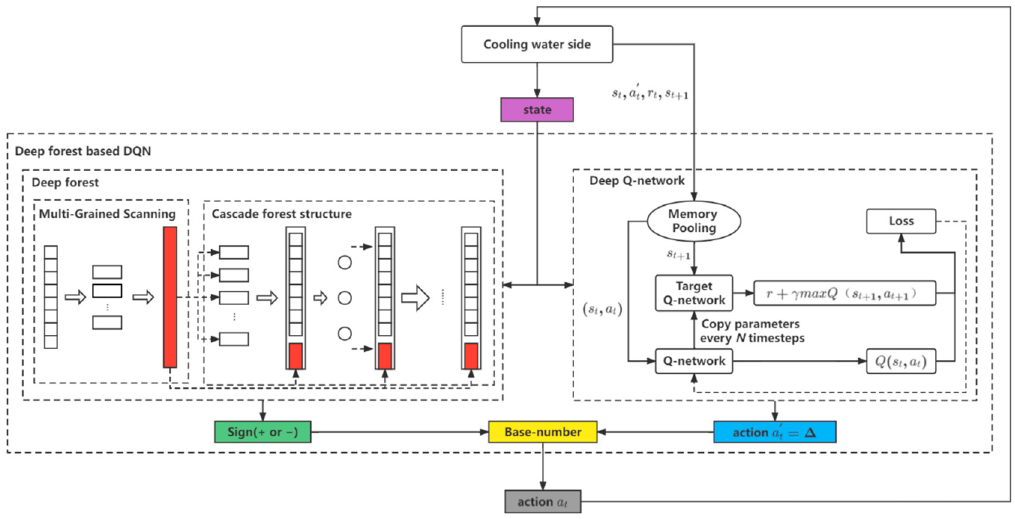
Figure 7. Overall framework of DF-DQN for cooling water system.